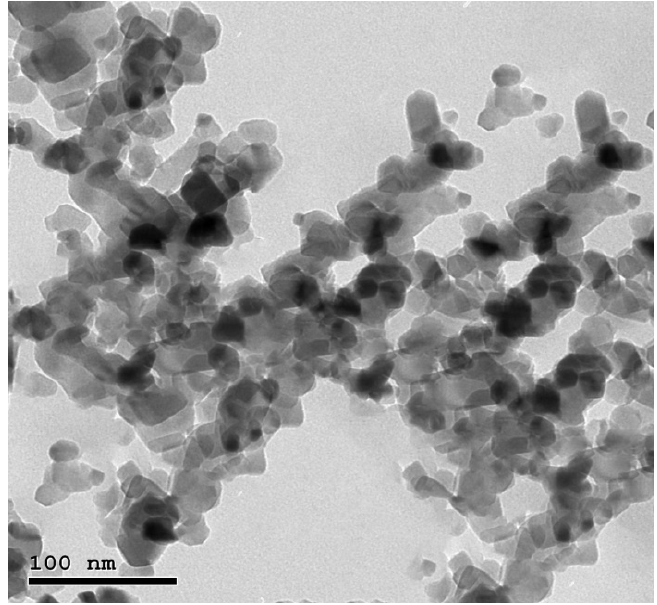
Figure 2. TEM image of MO-NPs illustrates the spherical in shape with clear edges without any agglomeration.